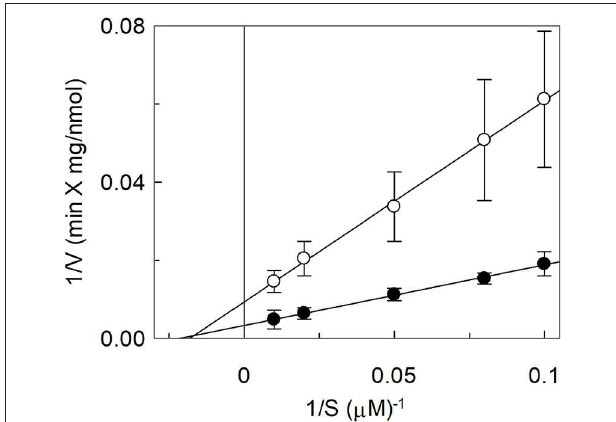
FIGURE 2 | Effect of cholesterol on kinetics of hASCT2 reconstituted in proteoliposomes. Purified hASCT2 was reconstituted in proteoliposomes prepared without CHEMS ( ◦ ) or with 75 µ g/mg phospholipids CHEMS (•) as described in Materials and Methods. Transport was started by adding indicated concentrations of [ 3 H]glutamine and 50mM Na-Gluconate to proteoliposomes containing 10mM glutamine. Transport was stopped after 15min and analysis of the data was performed according to linear Lineweaver–Burk plot as reciprocal transport rate vs. reciprocal glutamine concentration. Data are means ± SD of three independent experiments.